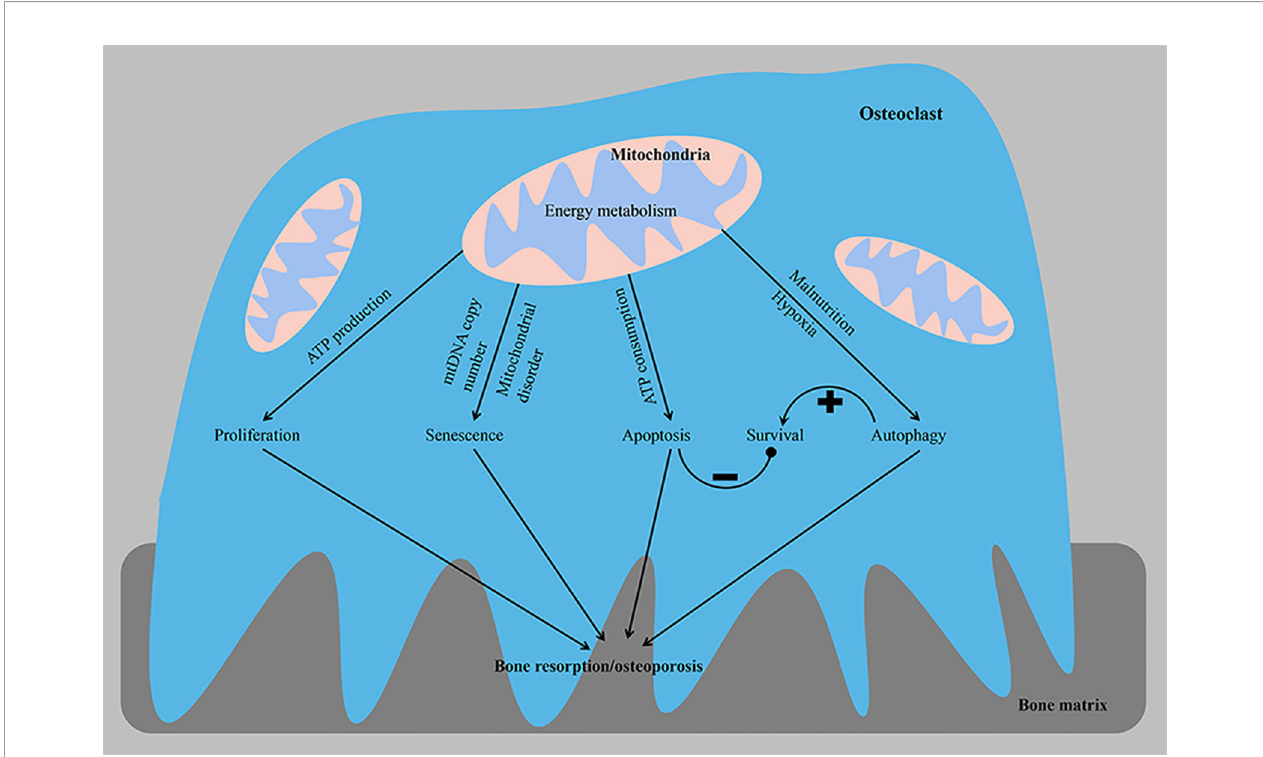
FIGURE 2 | From the perspective of energy metabolism, abnormal osteoclast proliferation, senescence, apoptosis and autophagy phenotypes lead to osteoporosis. The imbalance in homeostasis between osteoclast survival and the bone resorptive capacity is a key factor contributing to the development of osteoporosis. ATP, adenosine triphosphate; mtDNA, mitochondrial DNA. – , negative control; +, positive